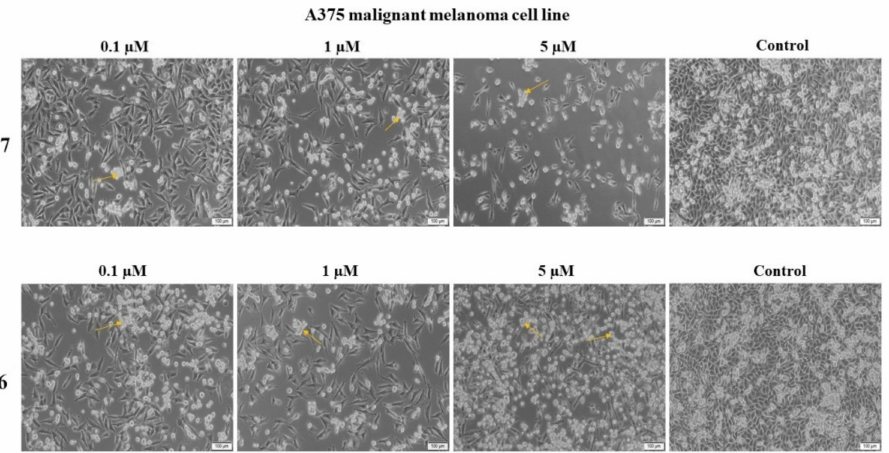
Figure 9. Morphological aspect of the A375 cells after the treatment with compounds 6 and 7 (0.1, 1, and 5 µ M) for 24 h. The arrows indicate the round and detached cells noticed following the treatment with compounds 6 and 7 . The scale bars represent 100 µ